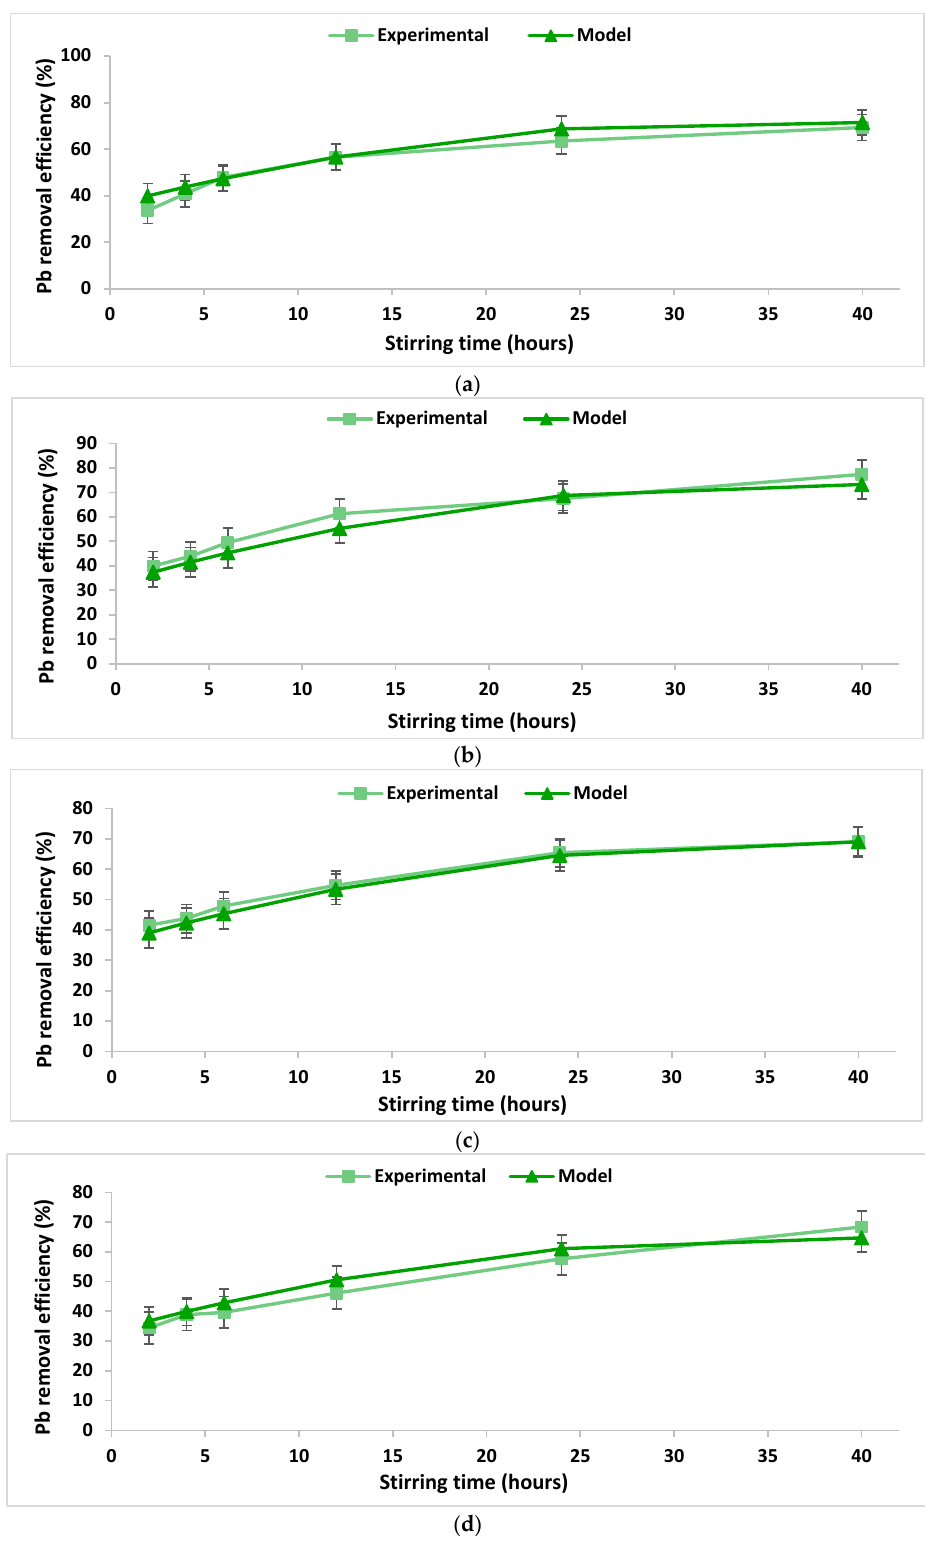
Figure 4. Lead removal efficiency over the stirring time using 2% chitosan washing solution at a S/L ratio of ( a ) 0.2 dec.fr. and ( b ) a S/L ratio of 0.1 dec.fr.; lead removal efficiency over the stirring time using 5% chitosan washing solution at a S/L ratio of ( c ) 0.1 dec.fr. and ( d ) 0.2